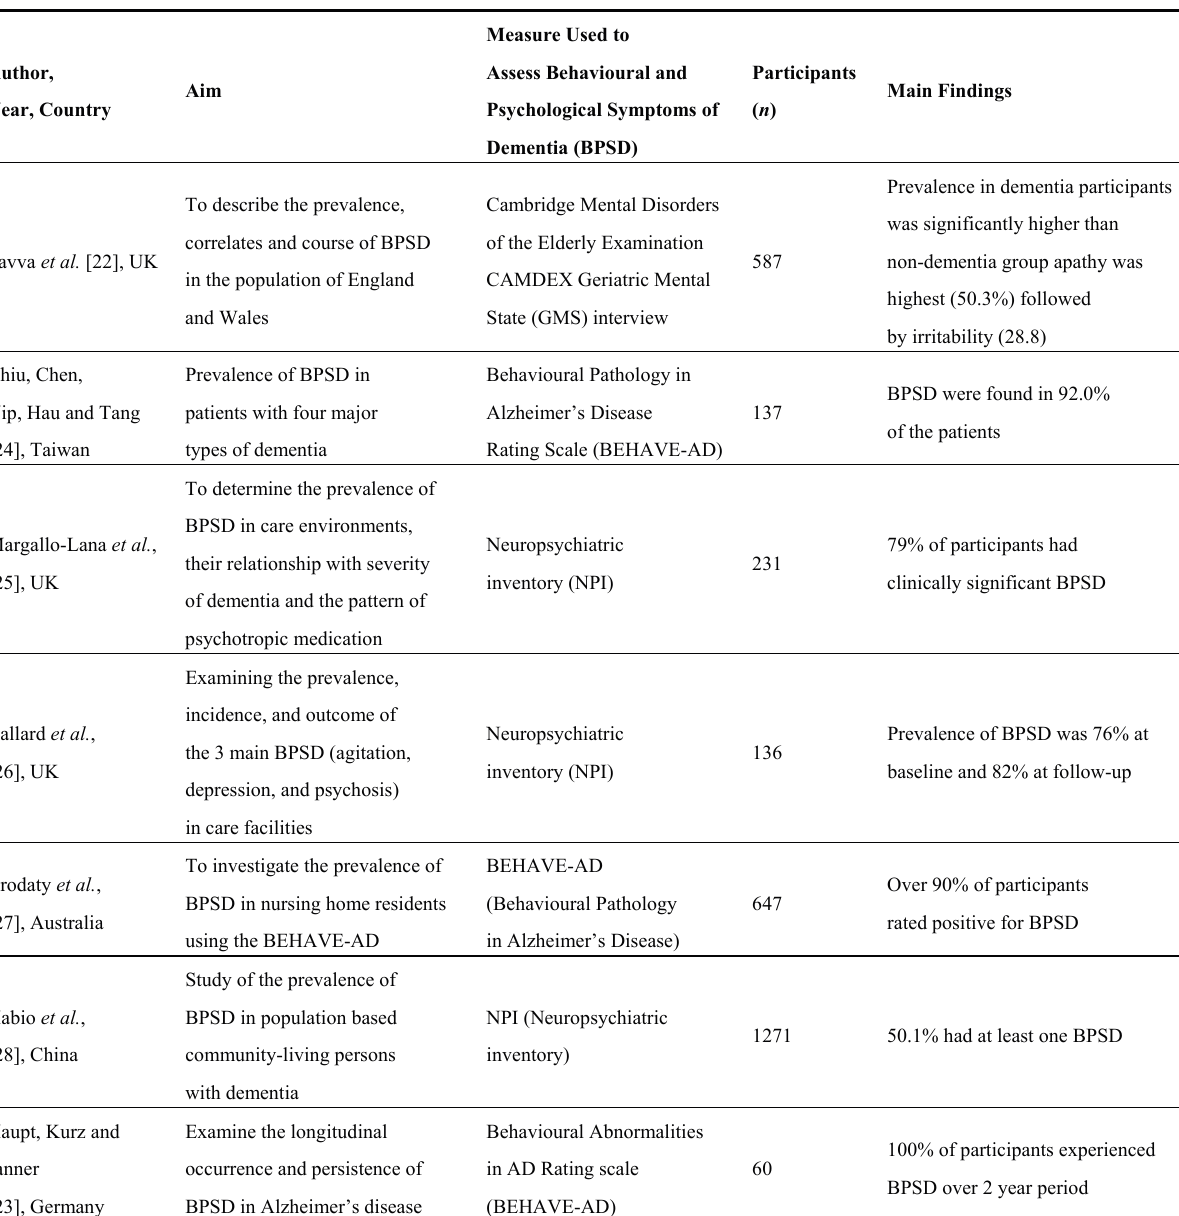
Table 1. Studies investigating behavioural and psychological symptoms of dementia (BPSD) in the general